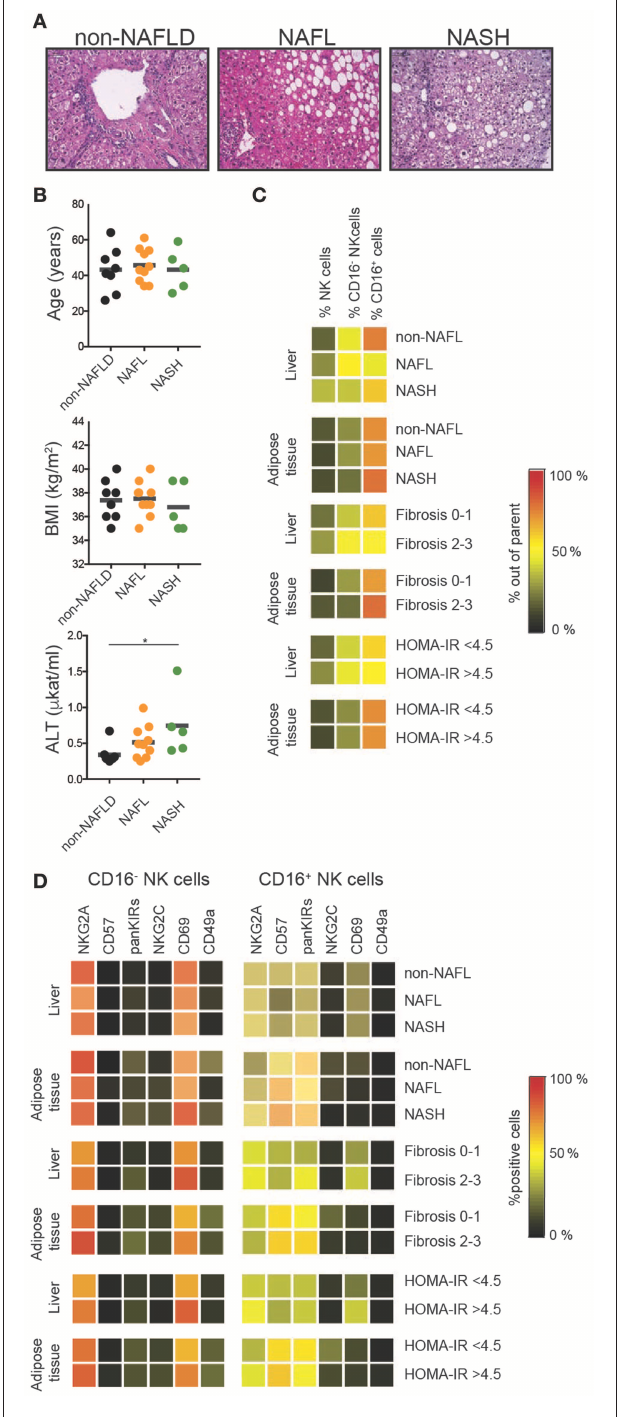
FIGURE 5 | Tissue NK cells in relation to patient disease characteristics. (A) Representative hematoxylin and eosin stainings on normal, NAFL, and NASH liver sections. (B) Distribution of the patients in relation to age, BMI, and levels of alanine transferase (ALT) as a proxy for liver damage. (C) Heat map showing mean frequency of total, CD16 + , and CD16 − NK cells for the indicated groups. (D) Heat map showing mean frequencies of NKG2A, CD57, KIRs, NKG2C, CD69, and CD49a expression on CD16 − and CD16 + NK cells for the indicated groups. * p <